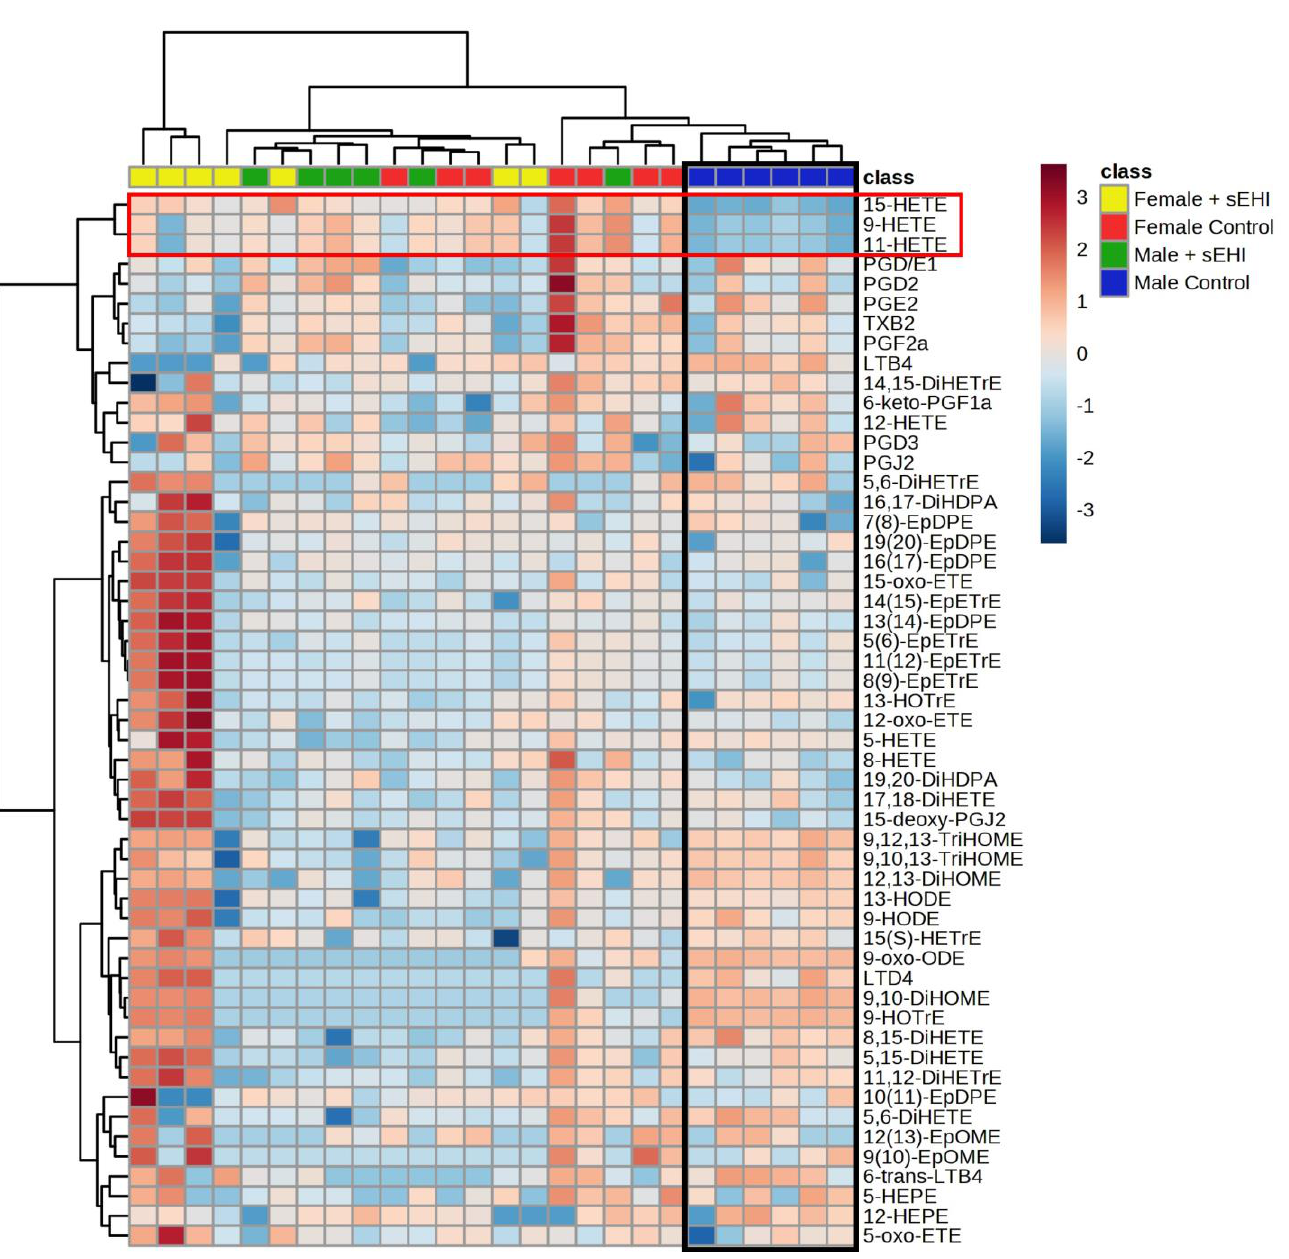
Figure 7. Hierarchical clustering heatmap of male and female control and sEHI-treated mice. The heatmap shows the relative concentrations of all measured oxylipins for the female sEHI-treated (color-coded yellow), female control (color-coded red), male sEHI-treated (color-coded green), and male control (color-coded blue) brain samples, with each column representing an individual sample. Throughout the heatmap, higher concentrations of the oxylipins are shown by shades of red and lower concentrations of oxylipins are shown by shades of blue. The black box highlights the clustering of control males together. The red box highlights three oxylipins that impact this clustering and are lower in control males. For definitions of oxylipin abbreviations see Table S1. A summary of the concentrations of each oxylipin analyzed in males and females, with and without the inhibitor, can be found in Table S3.